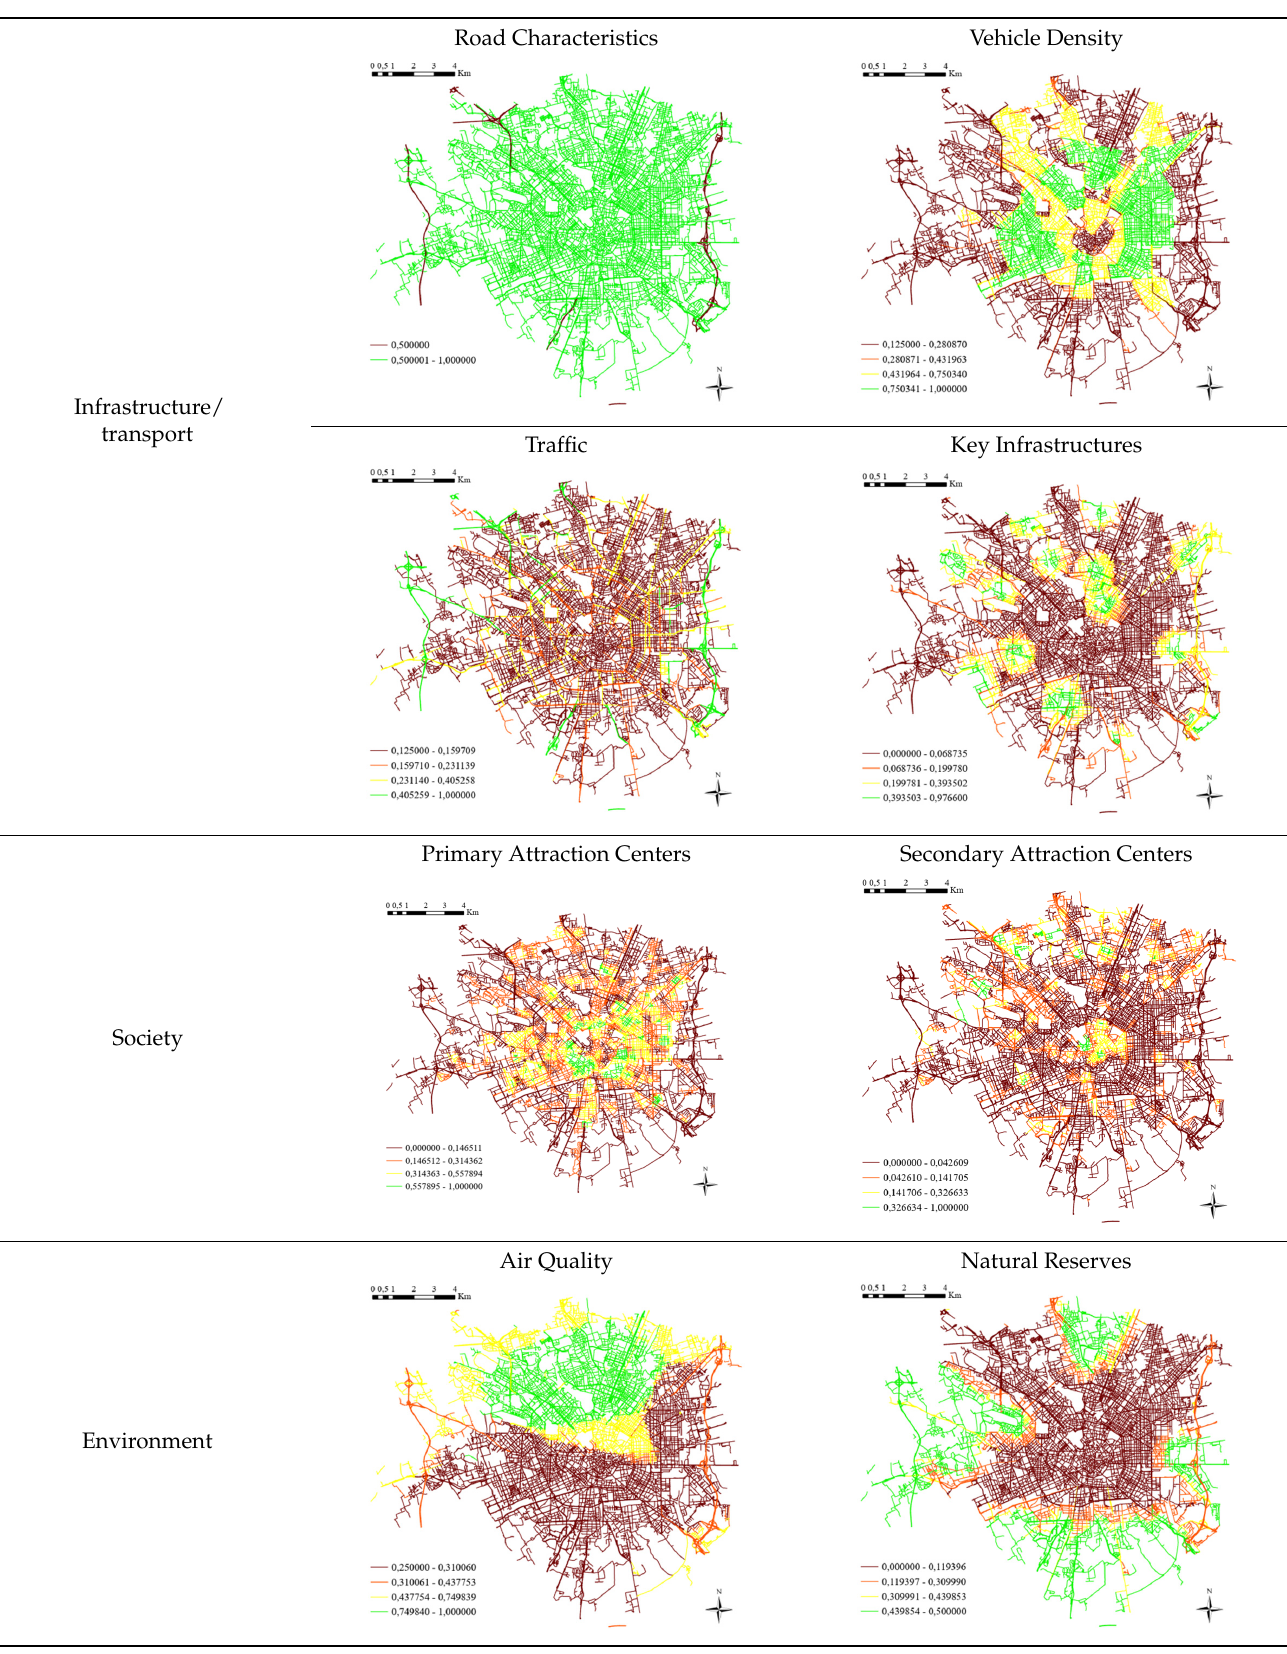
Table 3. Criteria maps of the city of